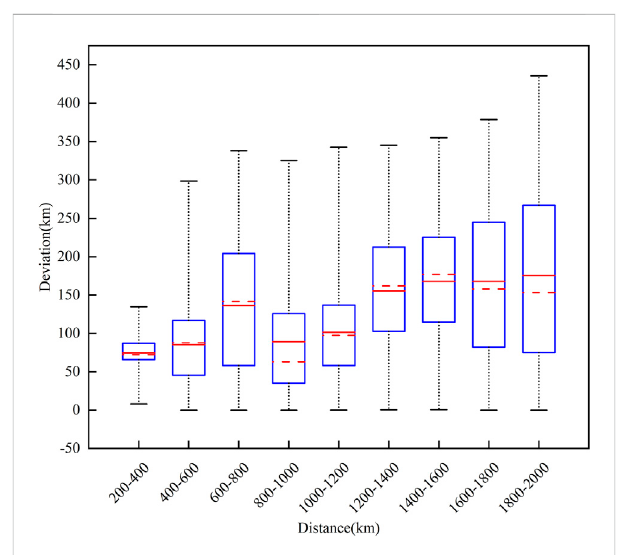
FIGURE 12 The changing trend ofthe single-sitelightning location deviation with